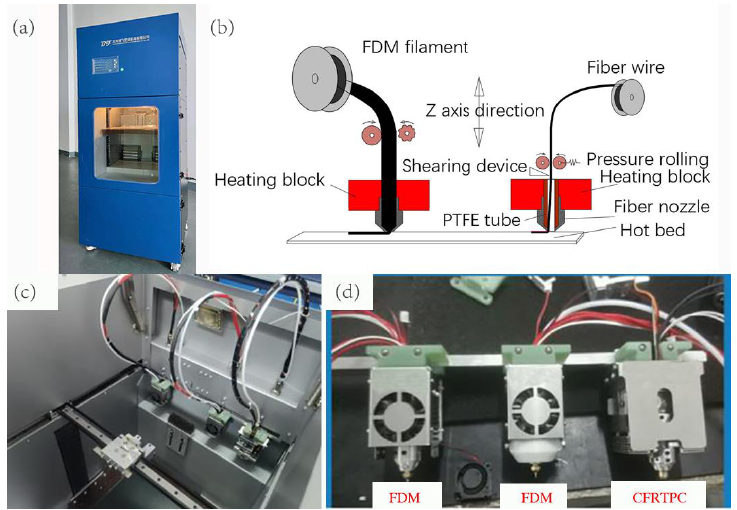
Figure 1. CFRTPC printer. ( a ) Printer appearance. ( b ) Extrusion principle diagram of two printing nozzles. ( c ) Printing platform. ( d ) Stand-alone printing head.